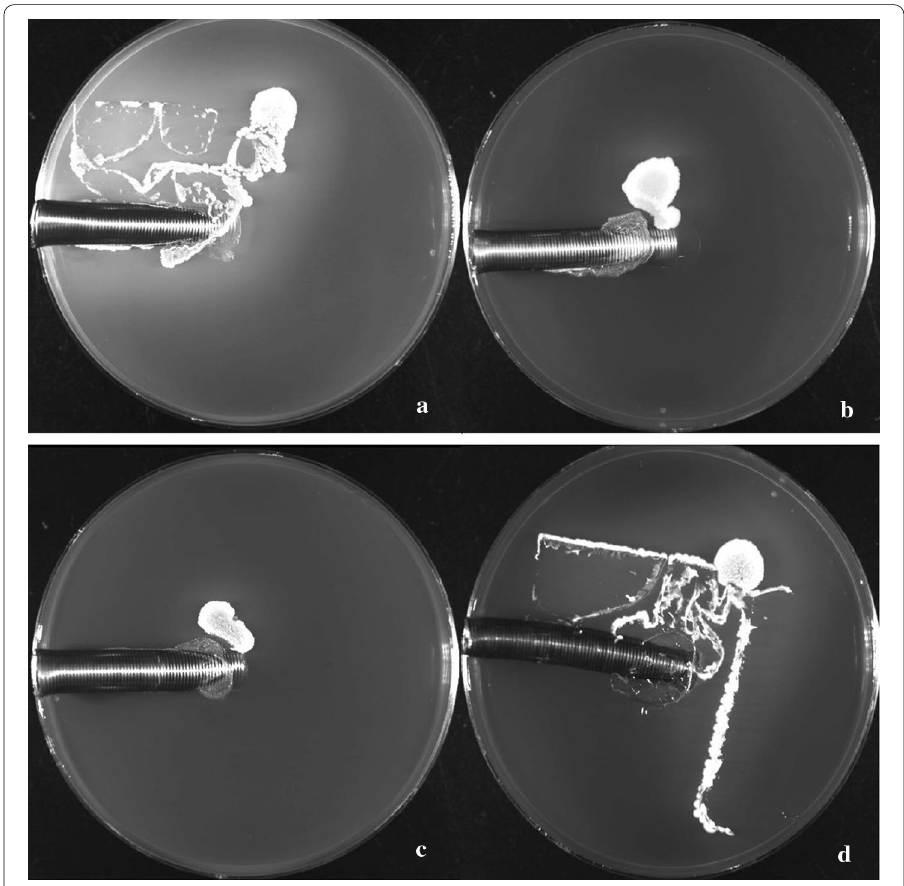
Fig. 2 Bacterial migration according to securement method ( a transparent dressing only, b Glubran Tiss2 only, c SecurePortIV only, d SecurePortIV and transparent